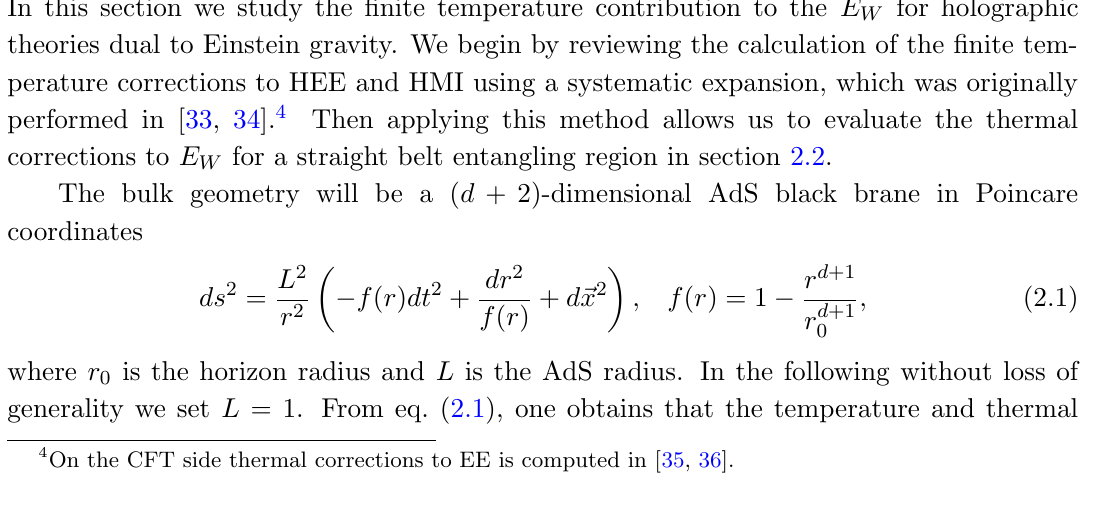
Figure 2 . Left : schematic con(cid:12)guration for computing E region) is connected. In this case E W is proportional to the area of (cid:6) min regions where the entanglement wedge is disconnected and (cid:6) min E W